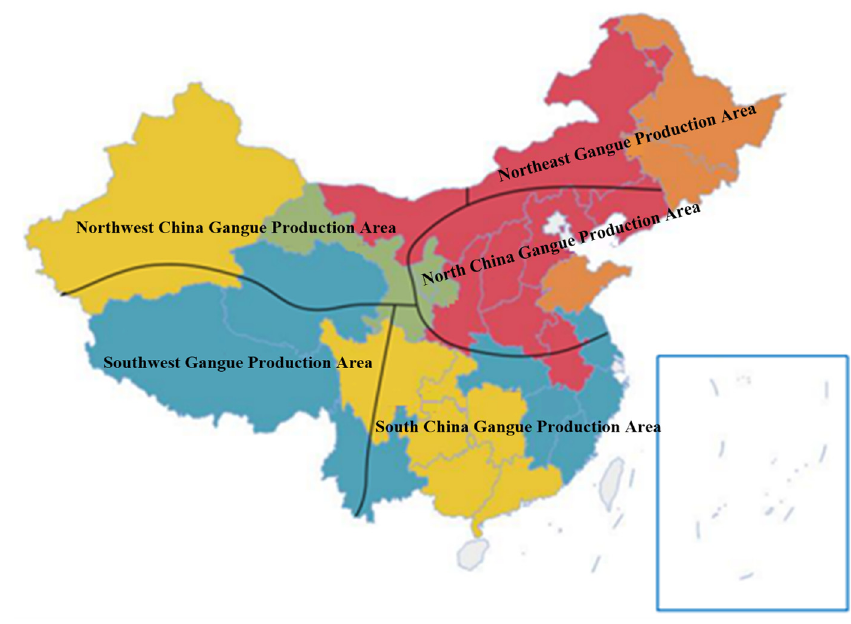
Figure 2. Distribution of gangue producing areas in China.